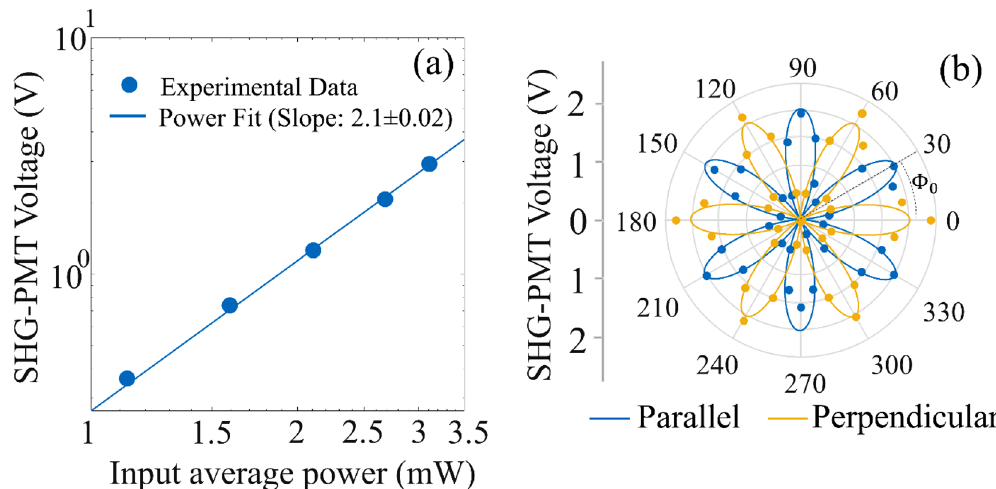
Figure 3. ( a ) Power dependence of SHG measurement. Filled circles correspond to experimental data and solid line corresponds to the linear fit of the log–log plot. The extracted slope is shown in the legend. ( b ) Polarization-dependent SHG measurement as a function of incident polarization direction. φ o refers to the initial offset between the armchair direction and the laboratory axes. Blue and orange filled circles correspond to experimental data for parallel and perpendicular polarization relative to the analyzer orientation. Solid curves correspond to theoretical fit to the experimental data points. (Created in MATLAB v9.6, R2019a, https:// in. mathw orks.